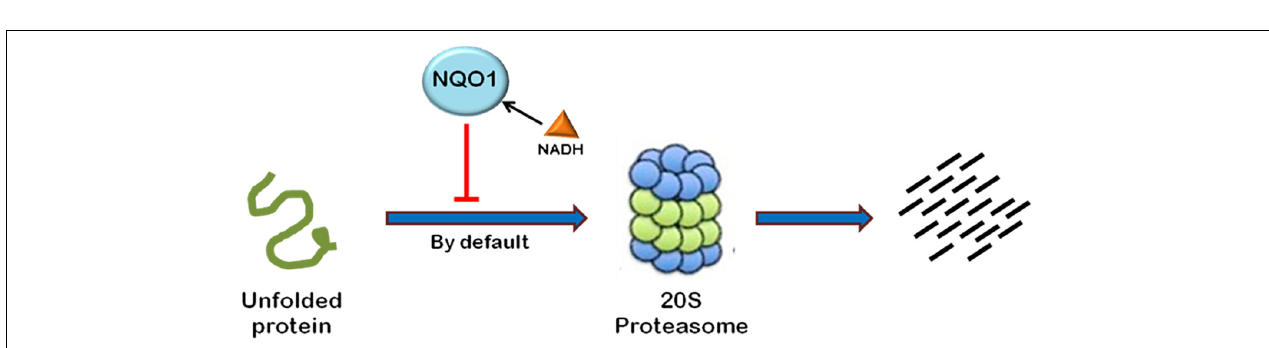
FIGURE 4 | Ubiquitin-independent proteasomal degradation pathway. The proteins containing unstructured regions or unfolded proteins are targeted to 20S proteasome for degradation by default. This pathway is independent of ubiquitination of the protein. Ubiquitin-independent 20S proteasomal degradation of proteins is regulated by NQO1. In the presence of NADH, NQO1 inhibits the degradation of proteins by 20S